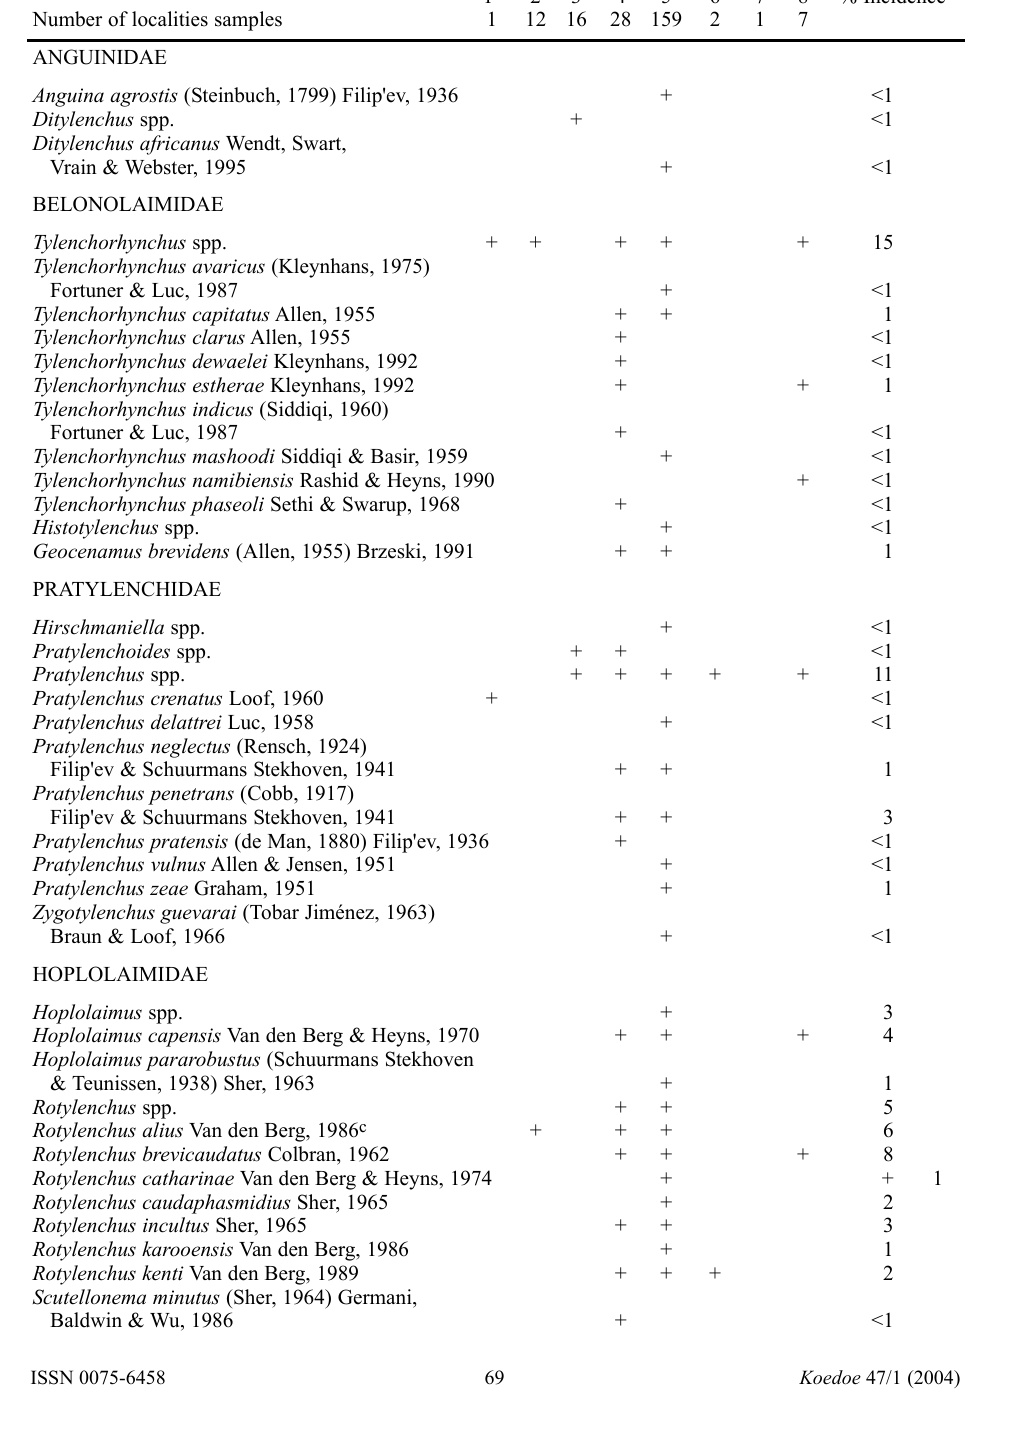
Table 1 Plant nematodes found associated with the Fynbos